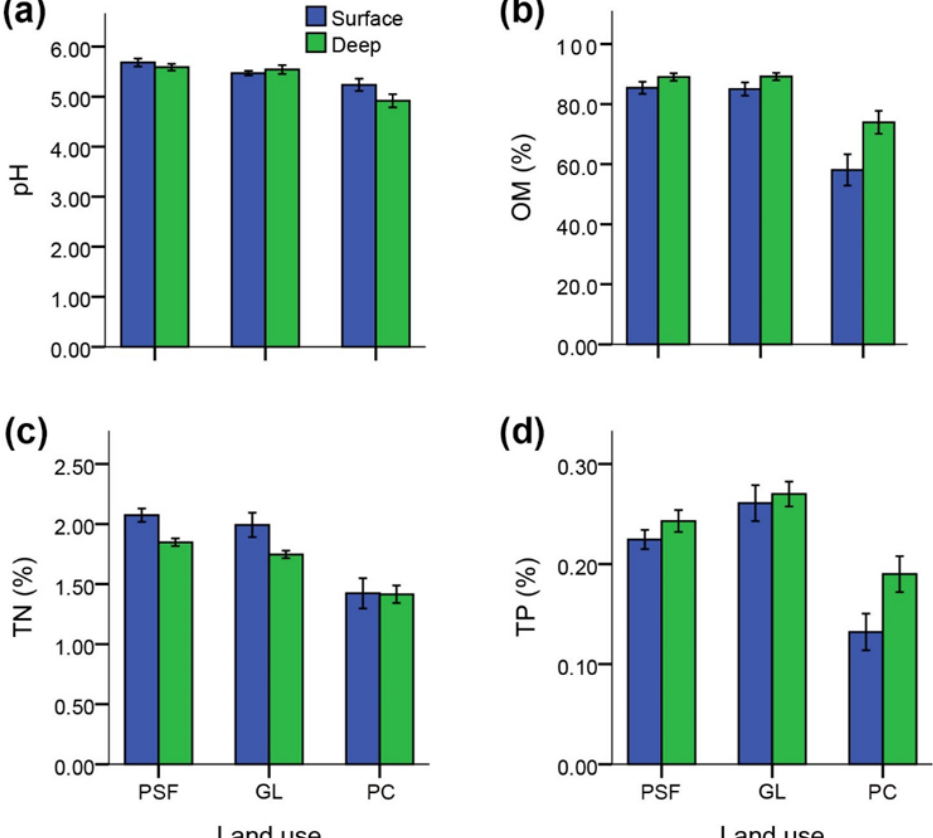
Figure 4. The difference in (a) pH, (b) organic matter (OM), (c) total nitrogen (TN) and (d) total phosphorus (TP) of peat soils in the different land use conversion classes in the study area. Average values for land conversion classes and standard error bars are shown. PSF=peat swamp forest, GL=grassland, PC=cultivation, surface peat layers (0–20, 20–40 cm), deep peat layers (40–60, 60–80, 80–100